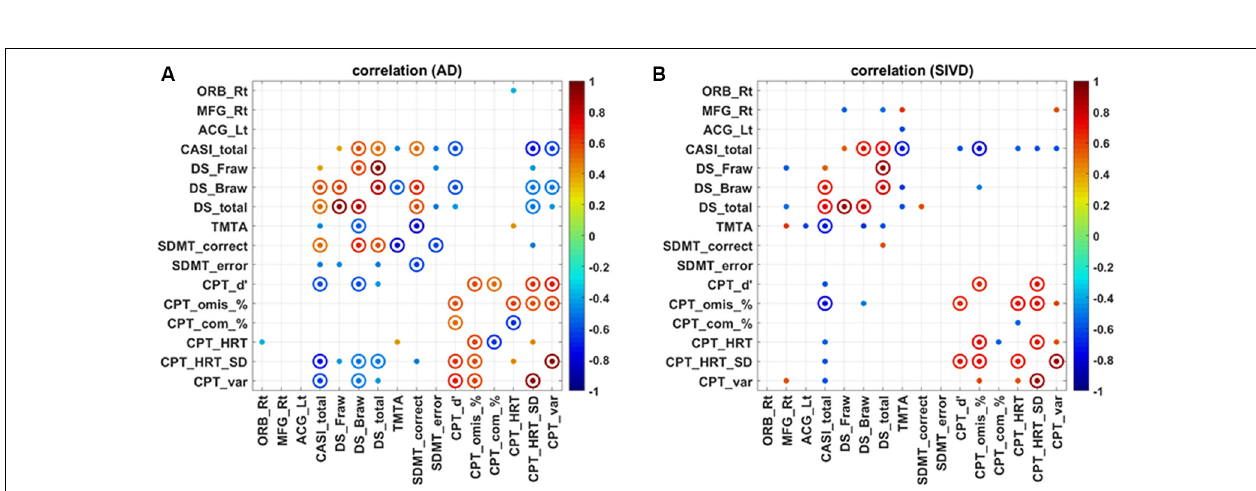
FIGURE 2 | Clusters with significant between-group differences. (A) The right middle frontal gyrus (MFG; SIVD < NC). (B) The left anterior cingulate gyrus (ACG; SIVD < NC). (C) The orbital part of the right superior/middle/inferior frontal gyrus (AD > NC). (D) The three significant clusters displayed on a single brain template (green: right MFG; blue: left anterior cingulate gyrus; red: orbital part of the right superior/middle/inferior frontal gyrus).